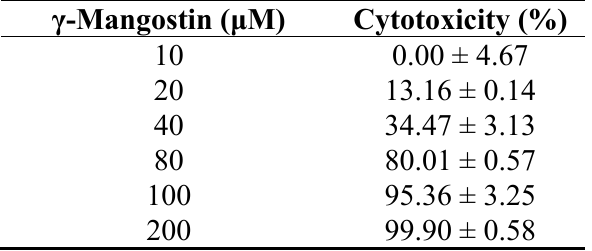
Table 1. Cytotoxicity of γ -mangostin in HT29 cells after 24 h by MTT assay.